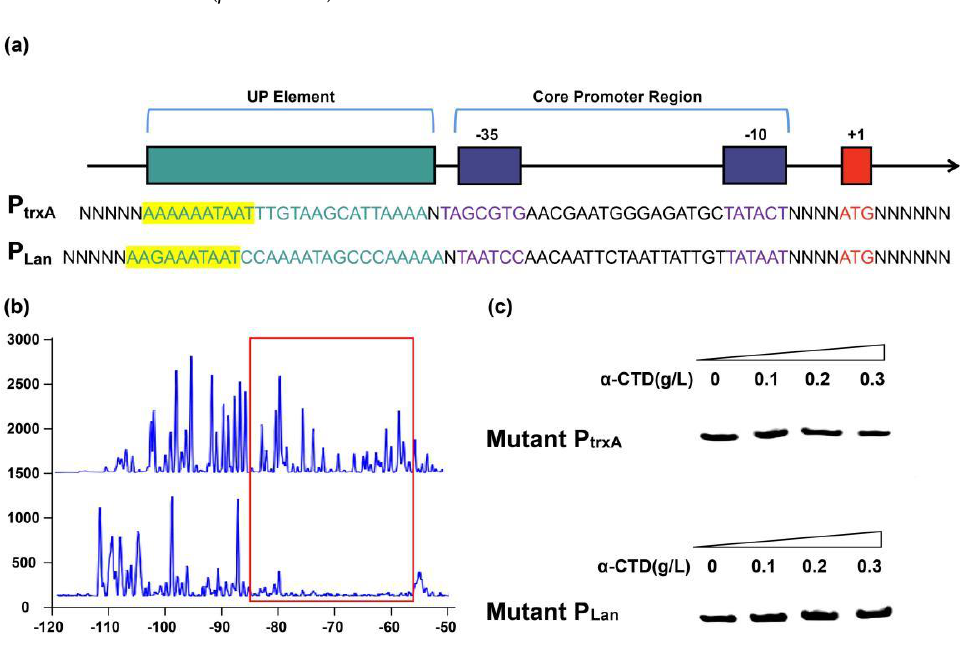
Figure 3. Characterization of α -CTD binding site of the promoters P trxA and P Lan . ( a ) Illustration of the UP element and the core promoter region in the promoters P trxA and P Lan . ( b ) α -CTD binding site was predicted by DNase footprinting in P Lan . ( c ) EMSA gels of α -CTD protein with oligonucleotide probes corresponding to mutant P trxA and P Lan with UPA or UPL truncated. The predicted binding sites of both promoters were thereby confirmed.